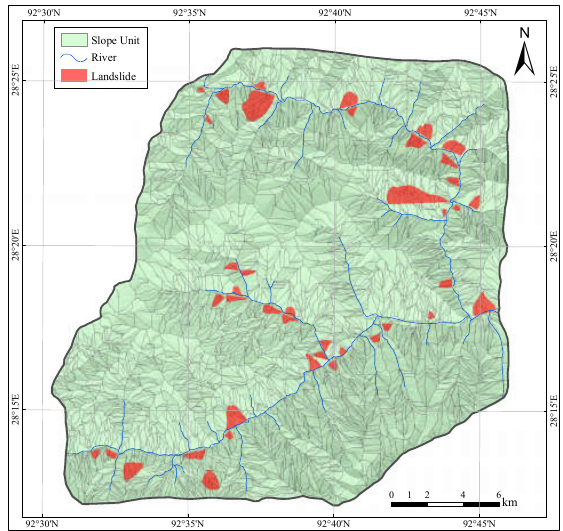
Figure 6. Division of slope units in the study area.